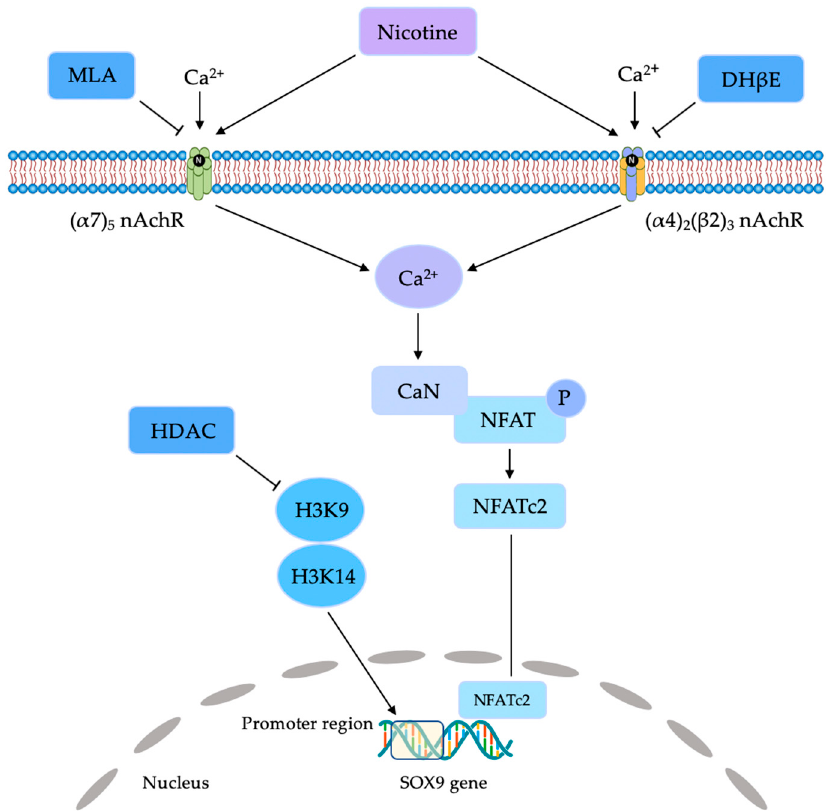
Figure 2. Schematic of nicotine-mediated signaling pathway with the stimulation of ( α 7)5 nicotine acetylcholine receptor (nAchR) and ( α 4)2( β 2)3 nAchR. CaN, Calcineurin; Dh β E, Dihydro- β -erythroidine, HDAC, histone deacetylase; H3K9, histone H3K9; H3K14, histone H3K14; MLA, methyllycaconitine; NFAT, nuclear factor of activated T cells; NFATc2, nuclear factor of activated T cells 2; P, phosphorylation.